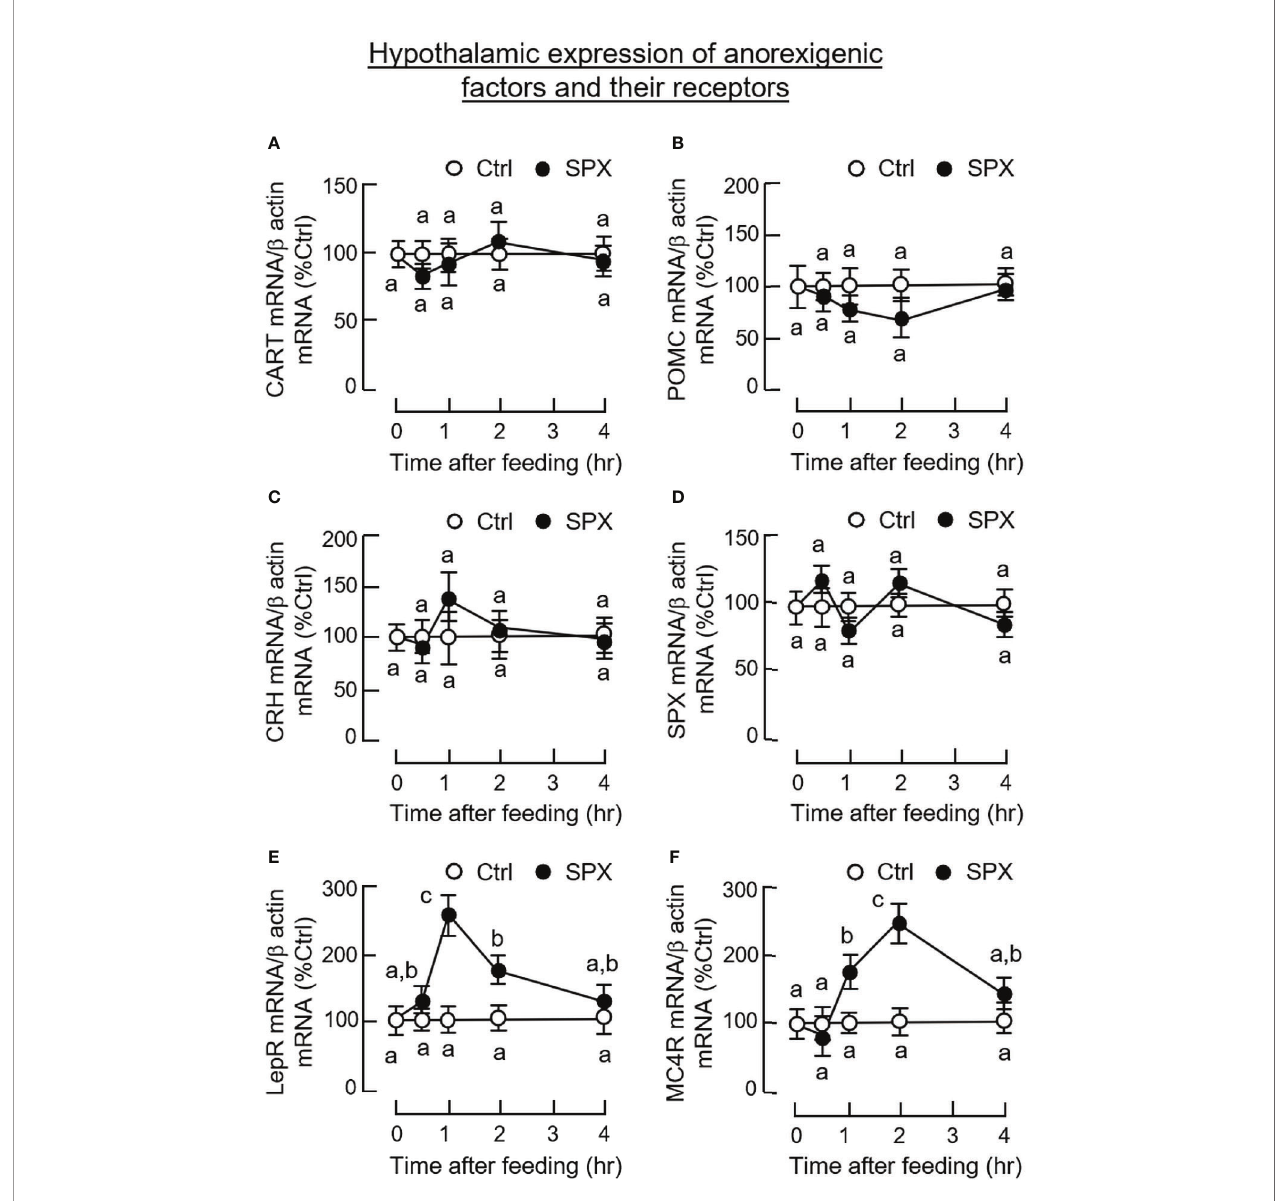
FIGURE 8 | Central administration of SPX on hypothalamic expression of anorexigenic factors and their receptors. ICV injection of SPX (1 nmole/mouse) was conducted in mice with parallel injection of arti fi cial CSF as control treatment. The hypothalamus was harvested at different time points and used for total RNA isolation followed by real-time PCR for transcript expression of CART (A) , POMC (B) , CRH (C) , SPX (D) , LepR (E) and MC4R (F) , respectively. In this study, b actin mRNA was used as the internal control. The groups denoted by different letters represent a signi fi cant difference at p <